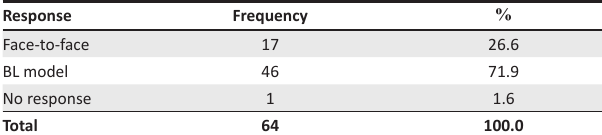
TABLE 1: Preference for learning